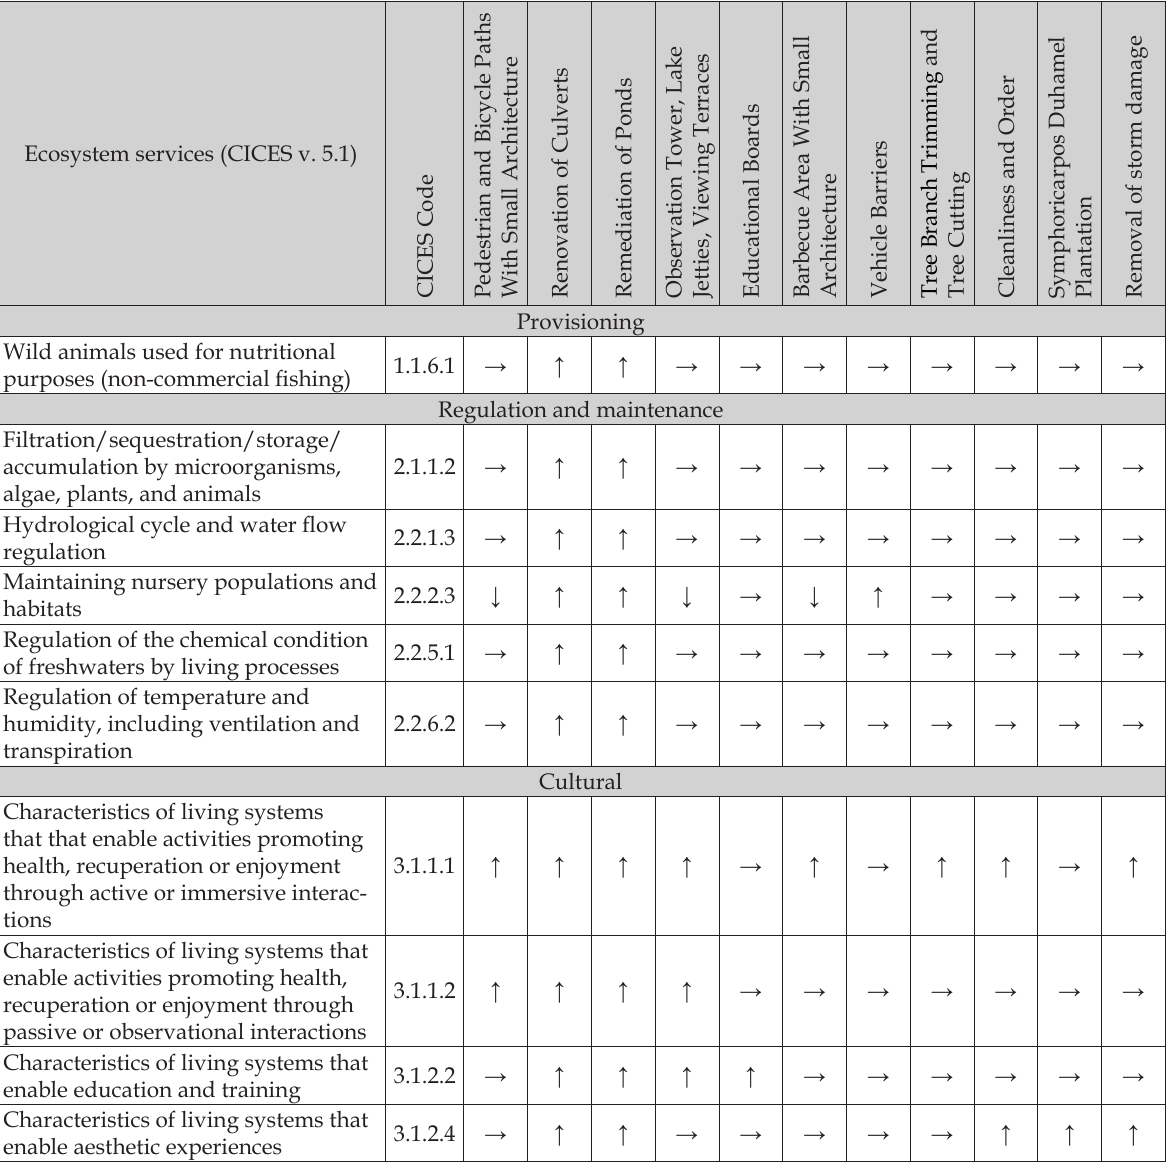
Table 4. Impact of public expenditure on the potential of the Szachty area for the provision of key ecosystem